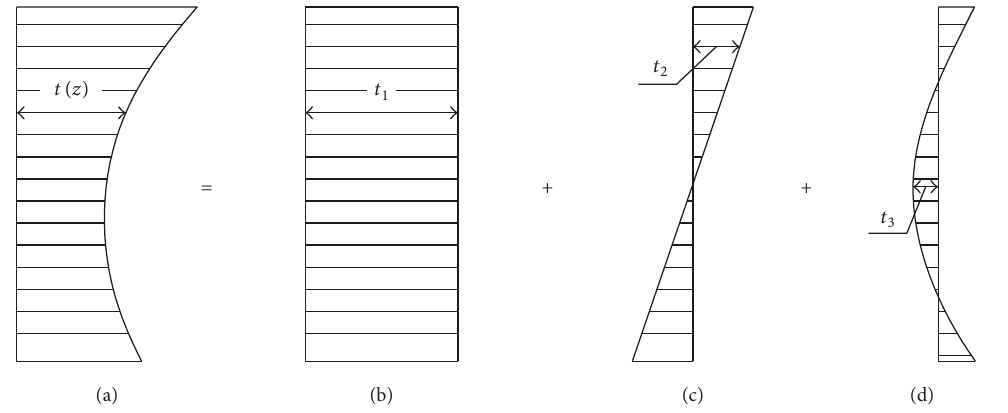
Figure 2: The diagram of temperature decomposition.